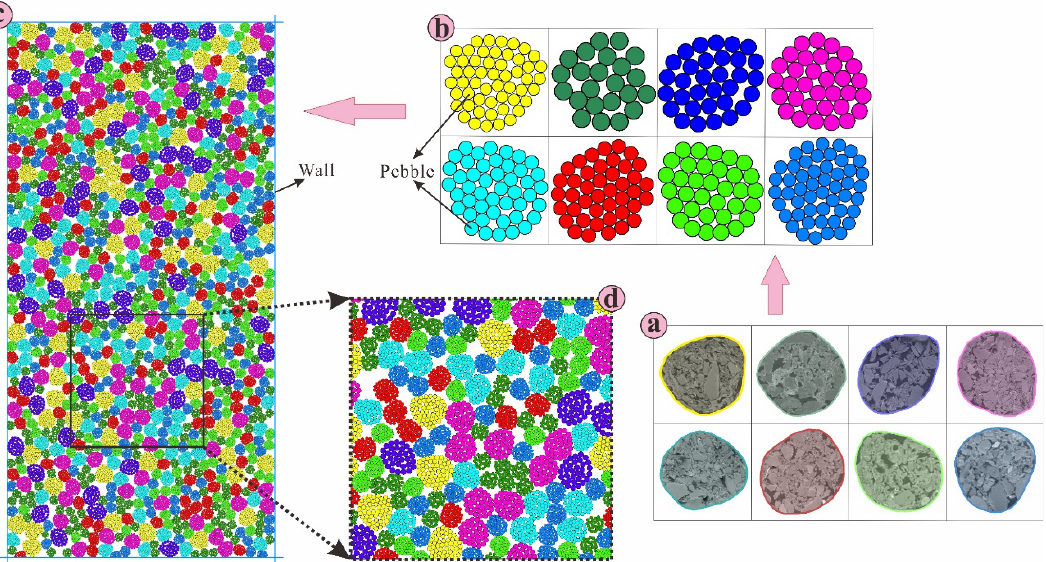
Figure 6. A full generation process of DEM model: ( a ) Geometric structure model, the outline of aggregates extracted from the SEM image; ( b ) Pebbles were used as silt particles to fill the extracted aggregate outline, and served as templates; ( c ) Intact numerical specimen generated by PFC method. Multi-colors denote various aggregates; ( d ) Enlarged detail of numerical specimen.